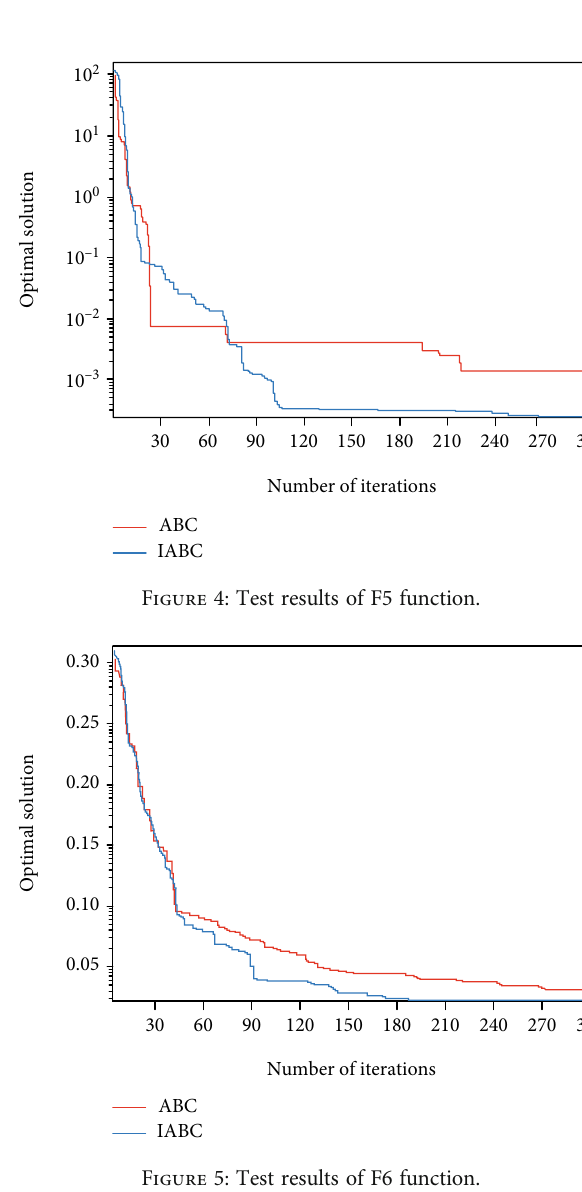
Figure 3: Test results of F2 function.